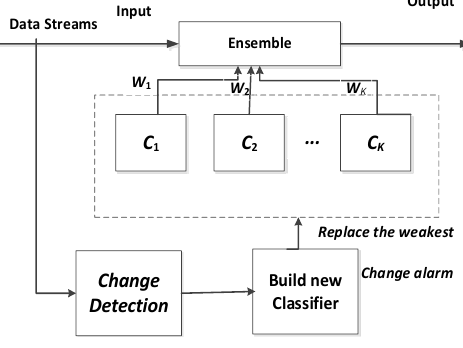
Figure 3. The framework of our method.